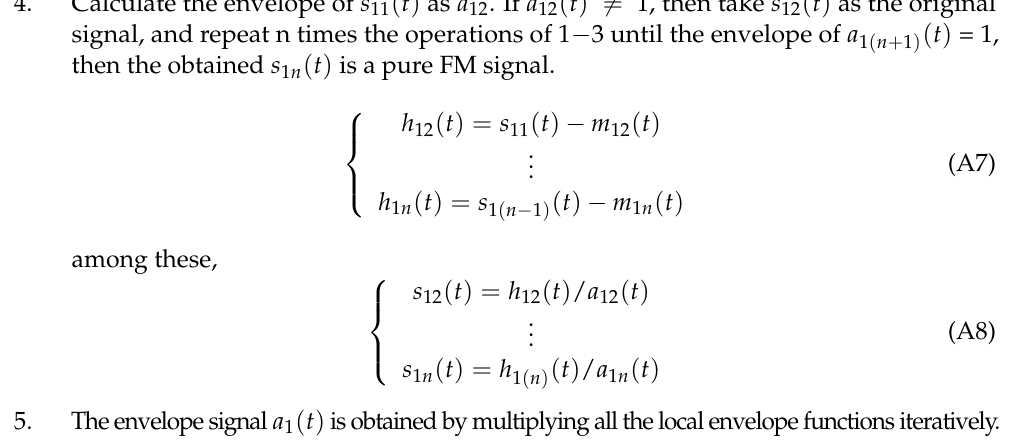
Calculate the envelope of s 11 ( t ) as a 12 . If a 12 ( t ) (cid:54) = 1, then take s 12 ( t ) as the